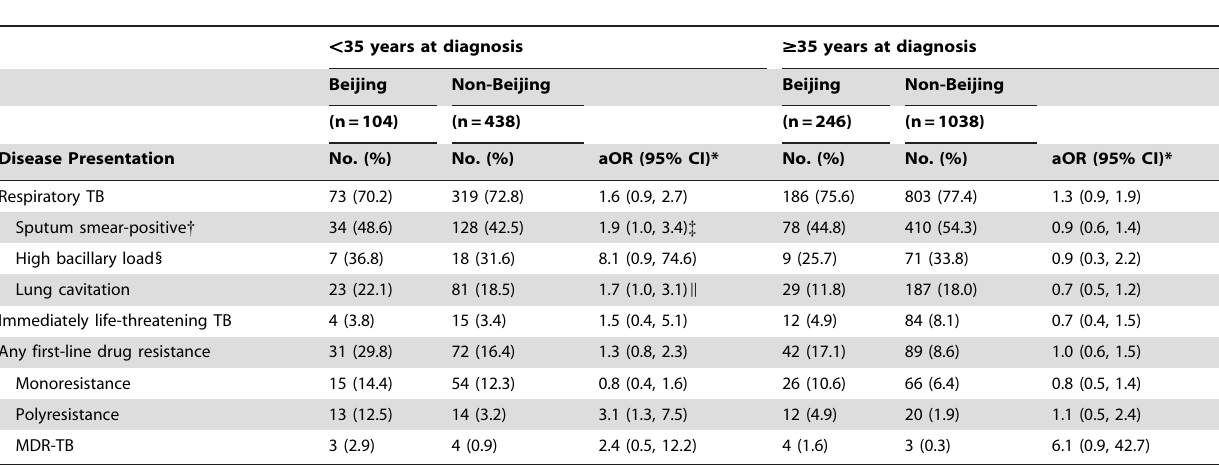
Table 4. Association between M. tuberculosis lineage and disease presentation based on age at